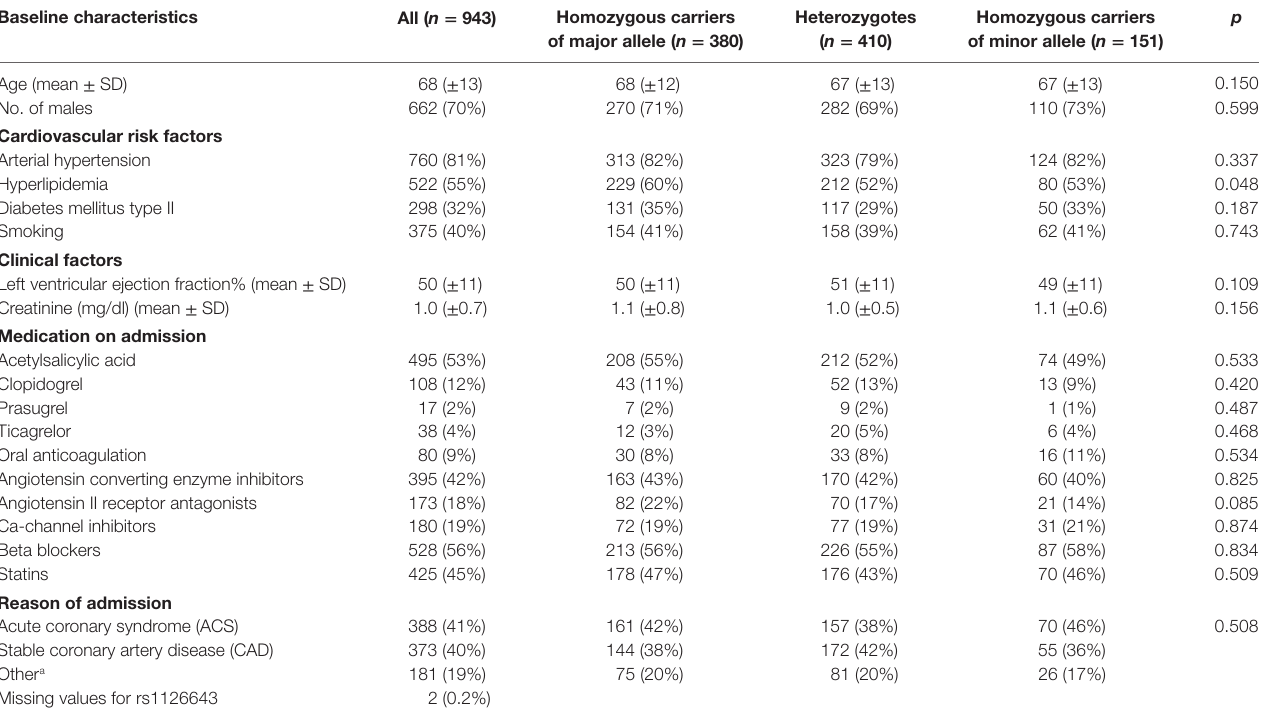
TaBle 1 | Baseline characteristics of the complete cohort ( n =